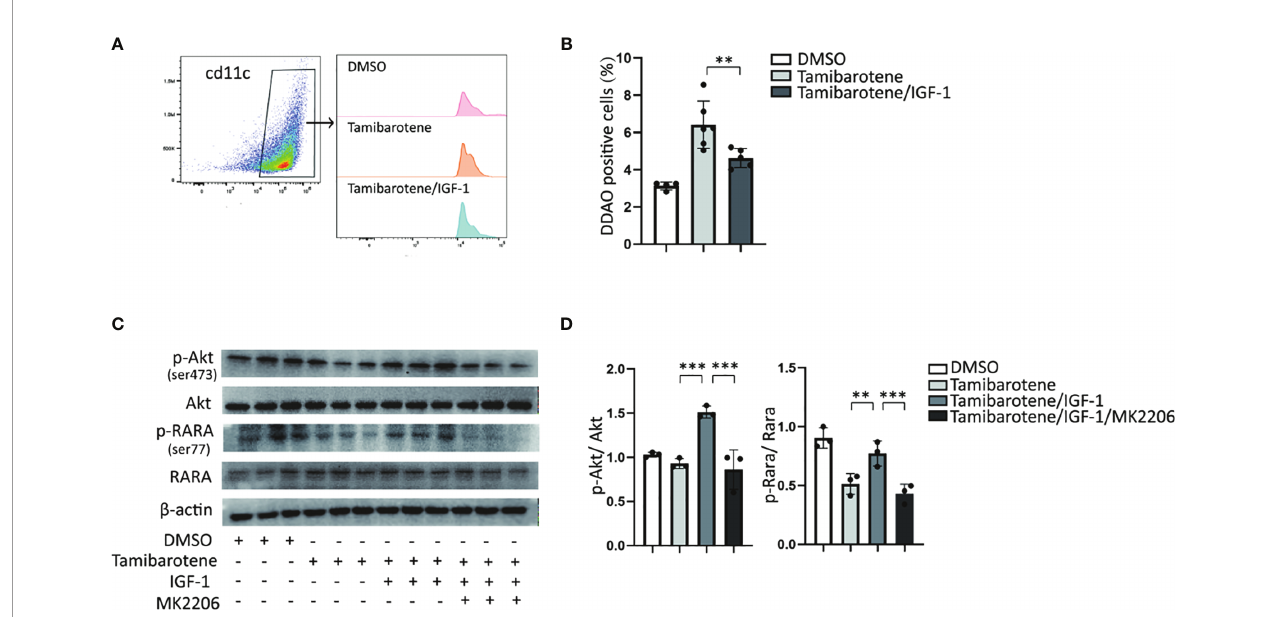
FIGURE 3 | IGF-1/Akt pathway inhibits the RA response through enhancing RARA phosphorylation. (A, B) RA signaling assessment. BMDCs cultured from RARE- lacZ transgenic mice were treated with DMSO, Tamibarotene (4mM) alone or with IGF-1 (500ng/ml).DDAO signaling were measured by fl ow cytometry after BMDC treated with substrate DDAOG. (C, D) BMDCs were cultured from normal SPF mice, and treated with DMSO, Tamibarotene, IGF-1 and Akt inhibitor (MK2206), then p-Akt, Akt, p-RAR a , RAR a expression were detected by western blotting. Data are from two or three independent experiments. Graph shows mean and SEM. Data were analyzed by one-way ANOVA. **p < 0.01, ***p <